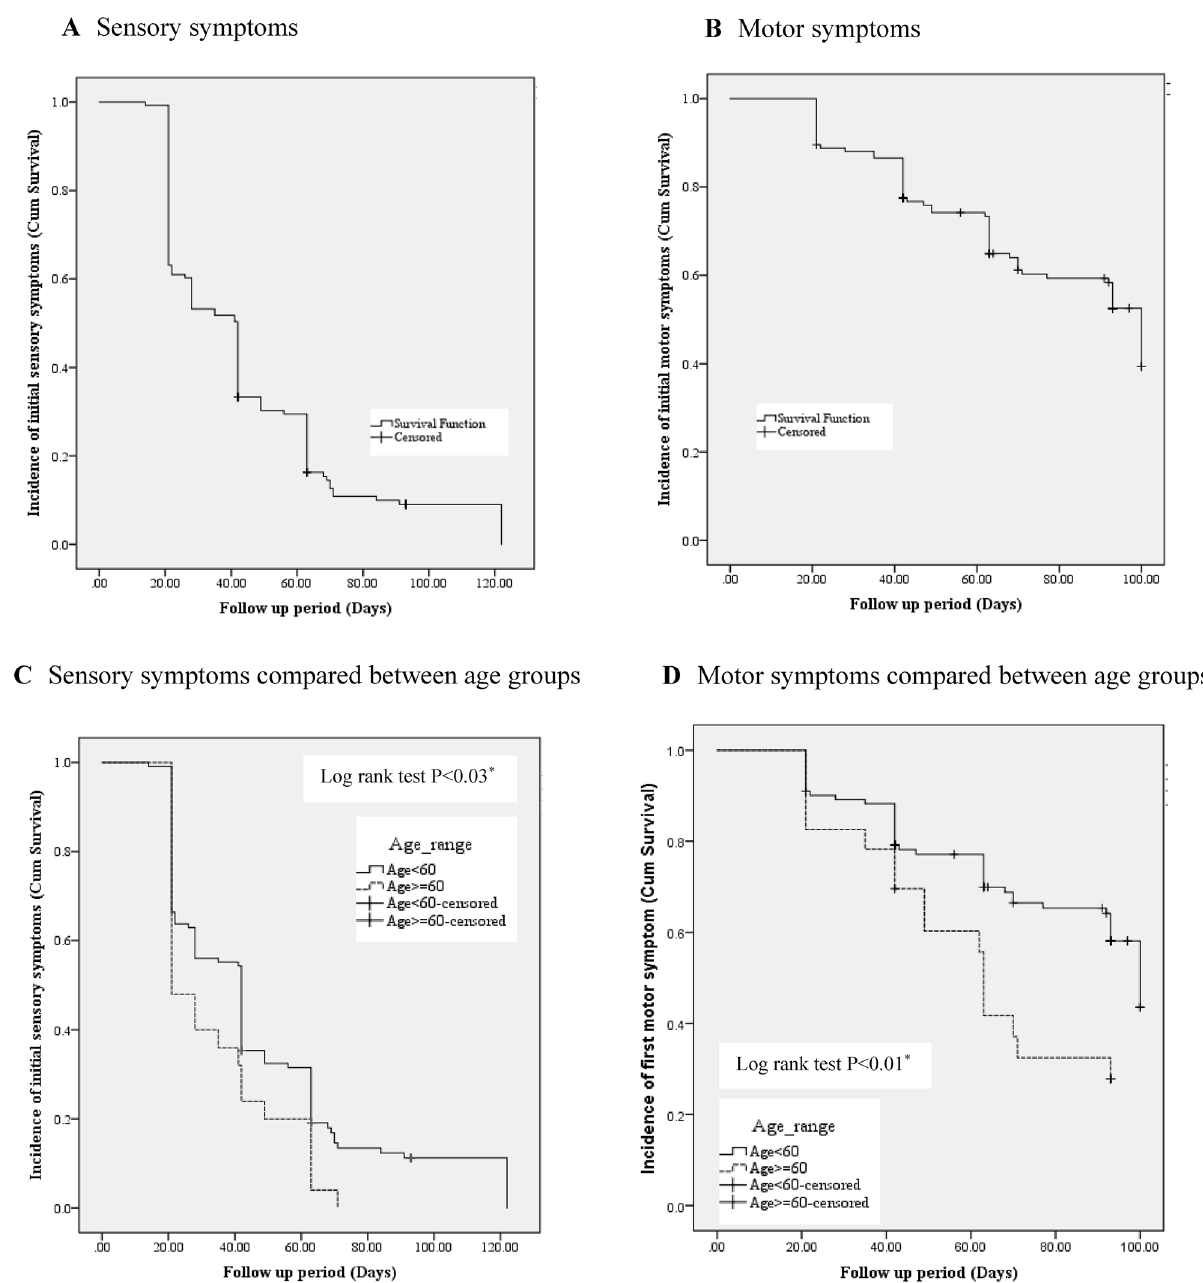
Figure 2. A Kaplan–Meier curve for the TIPN symptoms among women with breast cancer during received taxane-based chemotherapy. ( A ) Sensory neuropathy symptoms occurrence total women with breast cancer, ( B ) Motor neuropathy symptoms occurrence total women with breast cancer, ( C ) Sensory neuropathy symptoms occurrence between women with breast cancer who had equal or older than 60 years and women with breast cancer who had lower than 60 years, ( D ) Motor neuropathy symptoms occurrence between women with breast cancer who had equal or older than 60 years and women with breast cancer who had lower than 60